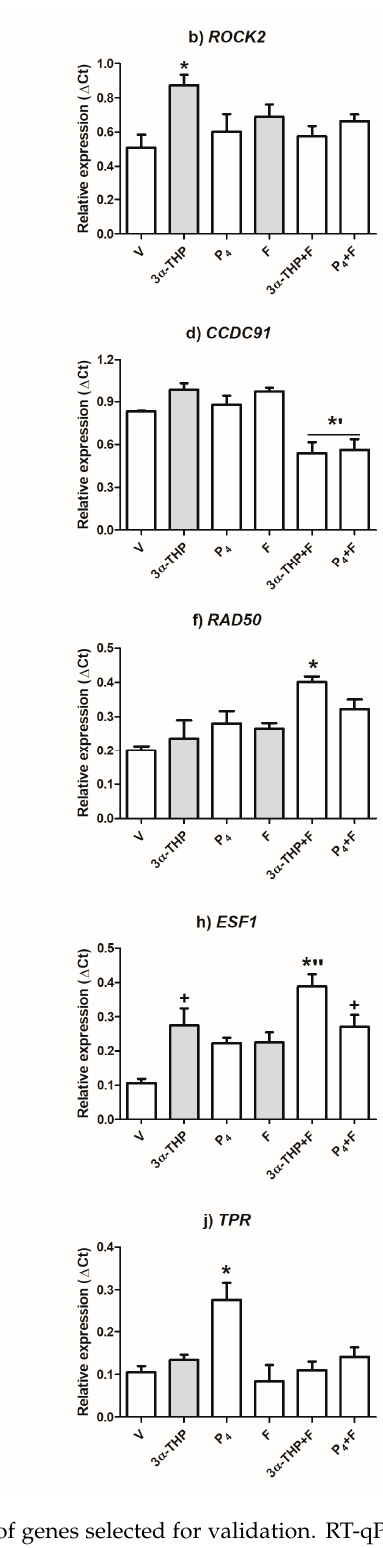
Figure 3. 3 α -THP, P4, and F regulate the expression of genes selected for validation. RT-qPCR was used to validate ten genes with a Fc > 1.5 in the microarray analysis. U87 cells were treated for 72 h with 3 α -THP (10 nM), P4 (10 nM), F (100 nM), 3 α -THP + F, and P4 + F. The internal control gene 18S ribosomal RNA was used to calculate the relative expression of each gene according to the Δ C t mathematic method. The grey bars represent the microarray results of the up-regulated genes by 3a-THP and/or F. Each column represents the mean ± standard error of mean (SEM), n = 3. + p < 0.05 vs. V; # p < 0.05 vs. V, and P4; #’ p < 0.05 vs. V, P4, and P4 + F; * p < 0.05 vs. all other treatments; *’ p < 0.05 vs. V and single treatments; *” p < 0.05 vs. V, P4, and F.